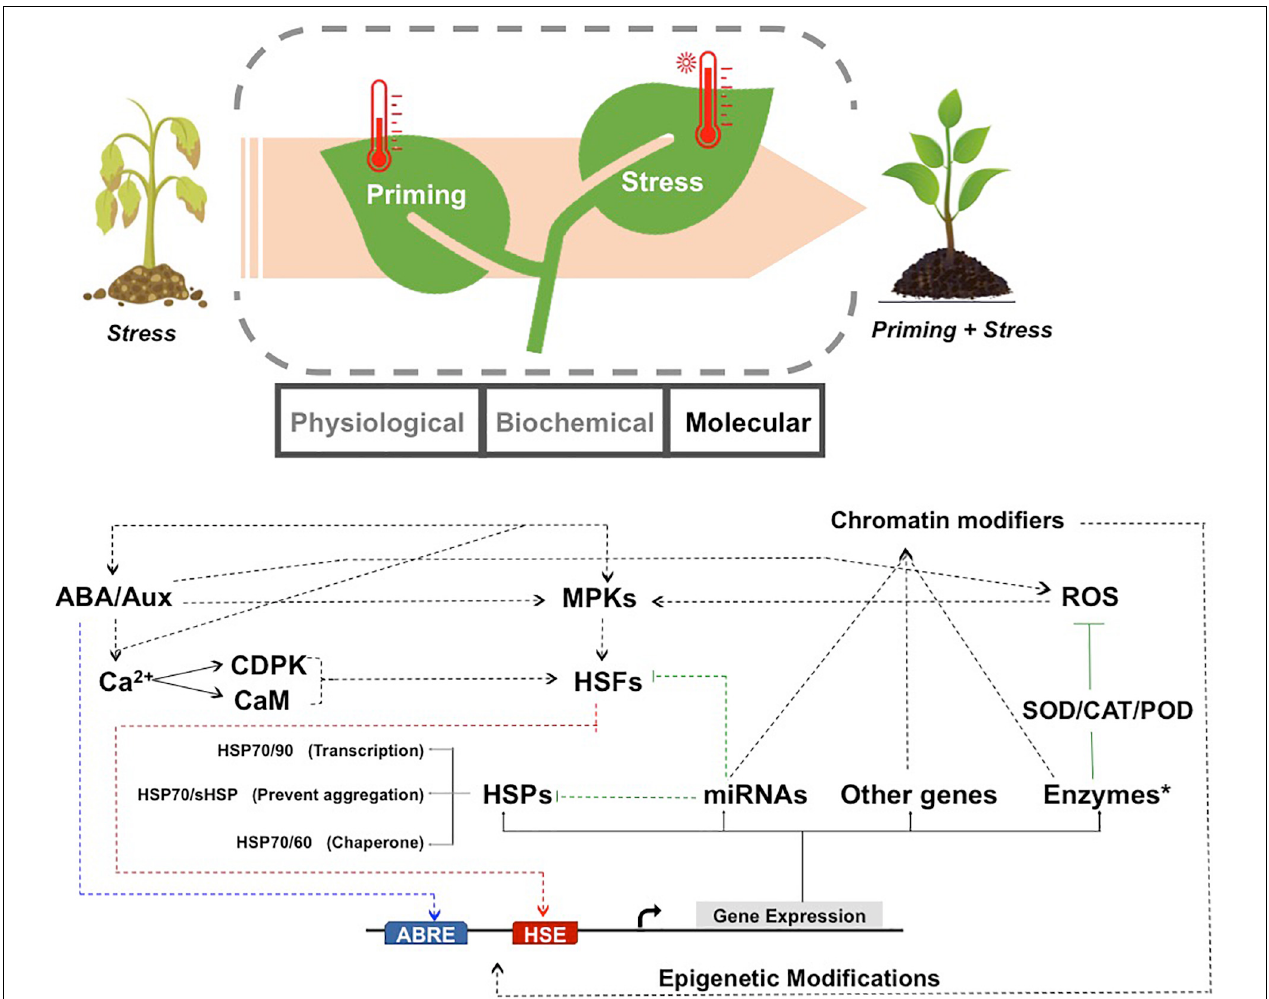
FIGURE 1 | Schematic representation to show the molecular networks operative during thermo-priming in plants. Plants under HTS perform better when primed with a short exposure to high temperature. Priming leads to changes in the physiological, biochemical and molecular framework. The molecular mechanisms responsible for thermo-tolerance and HTS memory are indicated below. Temperature priming activates the hormonal networks and ROS, which transmit the signals through the Ca 2 + dependent pathways and/or MPKs to regulate HTS-responsive gene expression. The Ca 2 + ions can be conducted through the CDPK or CaM pathways to activate the transcription factors. The HSFs (red) and hormones responsive transcription factors (blue) bind to their respective cis-elements and promote the transcription of HSPs, antioxidant enzymes (like SOD, POD, CAT), miRNAs and other genes. HSPs inhibit thermal denaturation of cellular proteins through increased chaperone capacity (HSP70/60), prevention of aggregation (sHSP/HSP70) and increased transcription (HSP70/90). miRNAs negatively regulate their targets genes, some of which include HSPs, HSFs and chromatin modifiers to trigger positive or negative feedback loops for retention of high temperature memory. On exposure to stress, primed plants show enhanced thermo-tolerance due to preparedness of the molecular machinery. ROS, reactive oxygen species; HSP, heat shock protein; HSF, heat stress transcription factor; MPK, mitogen-activated protein kinases; CDPK, calcium-dependent protein kinase; CaM, Calmodulin; ABA, abscisic acid; Aux, auxin; SOD, superoxide dismutase; CAT, catalase; POD, Peroxidases; HSE, heat shock sequence element; ABRE, abscisic acid response